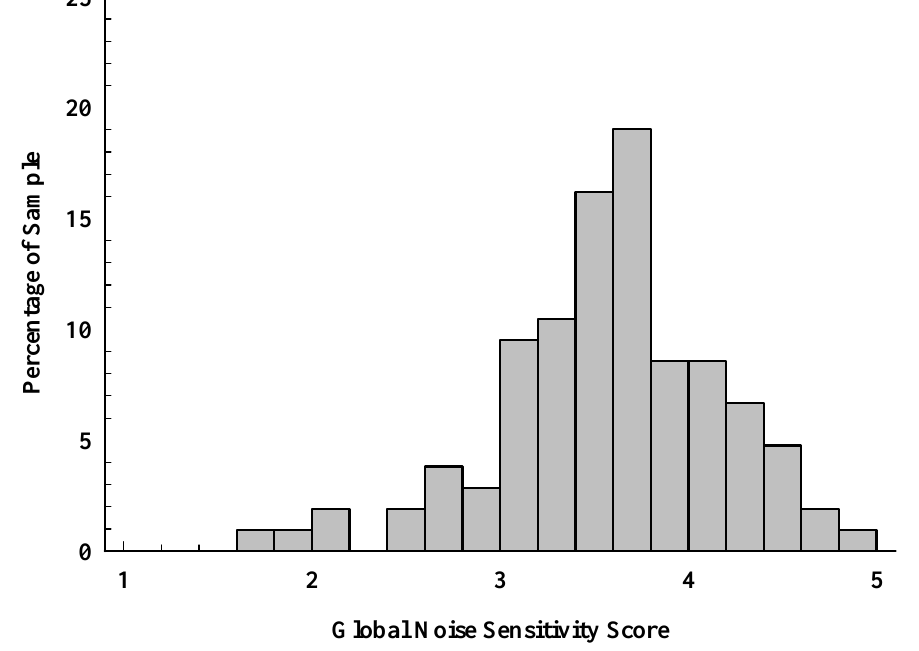
Figure 2. Histogram of Global Noise Sensitivity scores. Global scores are calculated as the mean ratings for all 35 items contained in the NOISEQ. Higher scores represent greater sensitivity to